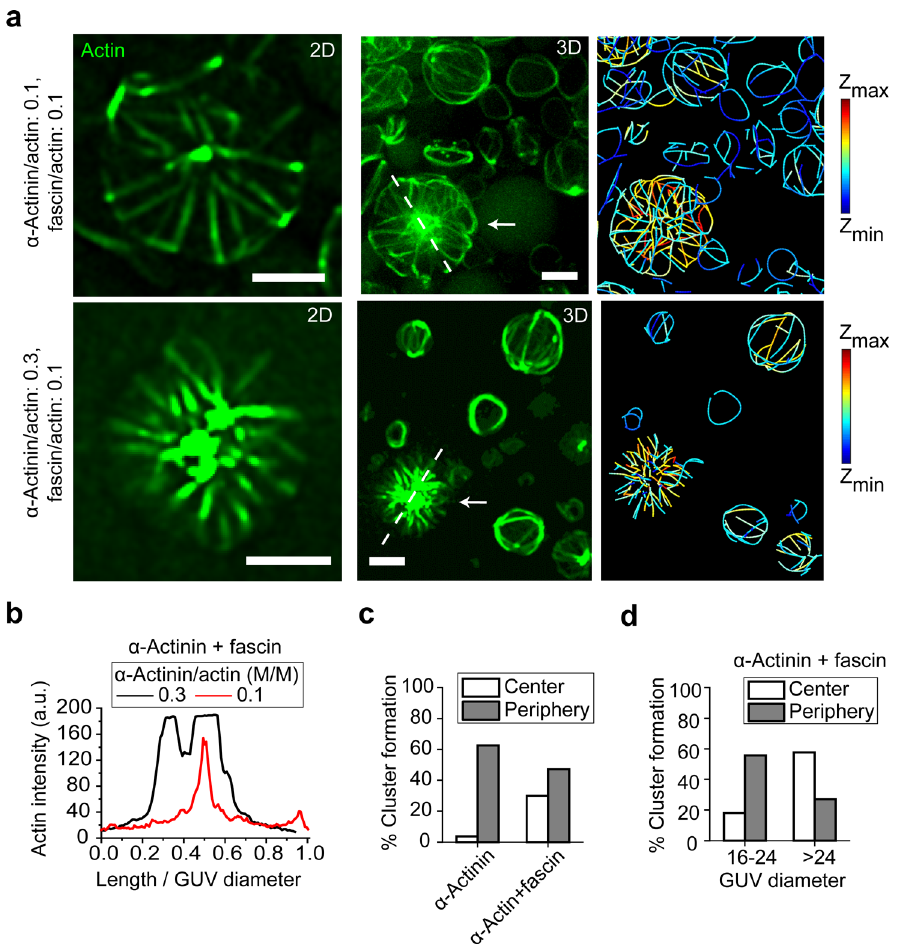
Fig. 3 GUV-size-dependent localization of F-actin clusters in the presence of α -actinin and fascin suggests cross-linker sorting and domain formation. a Representative 2D (left) confocal fl uorescence images of actin networks shown by arrows (3D-reconstructed image, middle) along with skeletonized (right) image of the GUV populations. α -actinin, 0.5 μ M (top), 1.5 μ M (bottom). Fascin, 0.5 μ M. Actin, 5 μ M. Scale bar, 10 μ m. b Actin fl uorescence intensity along the length of dashed lines drawn across the two GUVs in ( a ) normalized to the GUV diameters. c Cumulative probability (for all α -actinin concentrations) of the aggregation of cross-linked actin with/without fascin in GUVs with diameter >20 μ m. α -actinin – fascin – actin bundles tend to shift cluster localization from the periphery to the center of GUVs. Probabilities do not add to 100% because a portion of actin bundles do not cluster at either the center or the periphery. N GUVs>20 μ m = 167 [87 ( α -actinin), 80 ( α -actinin + fascin)]. In our analysis, only a minority of vesicles with encapsulated α - actinin – actin-bundle structures and encapsulated α -actinin – fascin – actin-bundle structures did not form clusters. d Cumulative probability (for all α -actinin concentrations) of the aggregation of cross-linked actin in large GUVs in the presence of both α -actinin and fascin. Larger GUVs facilitate centering of clusters. A portion of actin bundles do not cluster either at the center or at the periphery. N analyzed GUVs>16 μ m = 87 (61 [17 – 24 μ m], 26 [>24 μ